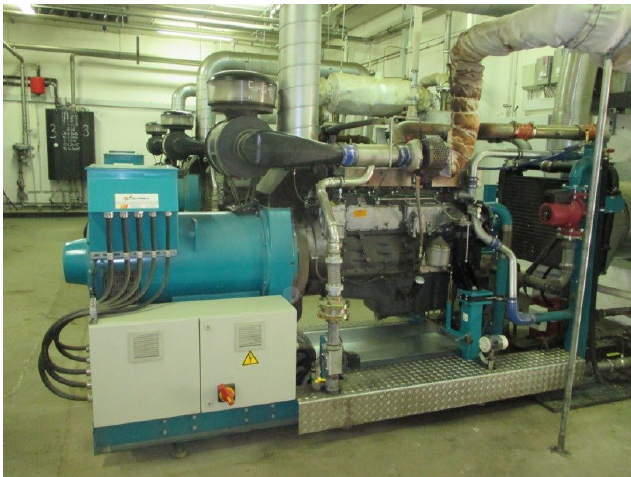
Fig. 2. Demonstration of a co-generation unit in the BS 1 biogas station